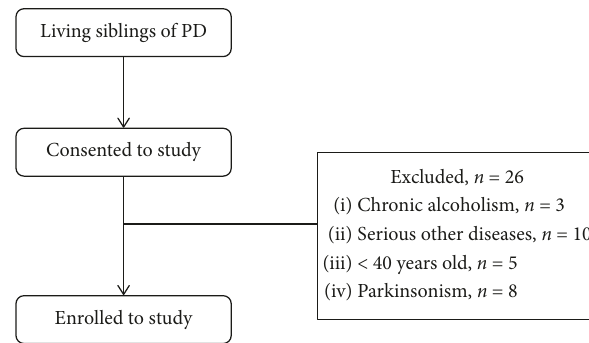
Figure 1: Flow diagram of subject